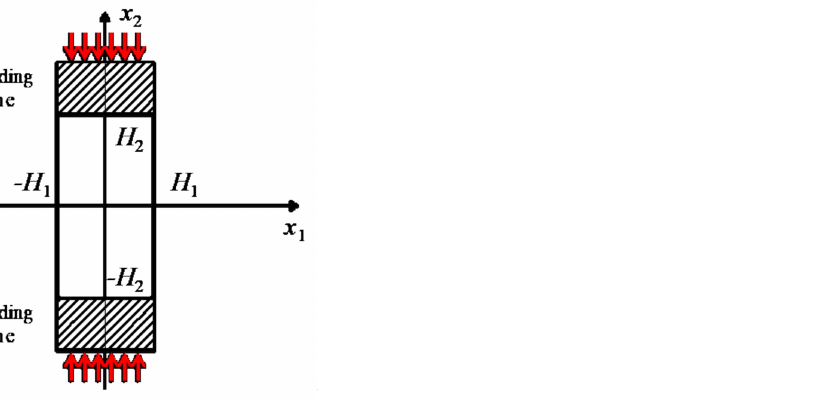
Figure 3. A 2D model of a sample of particulate material under uniaxial compression applied through a stiff loading